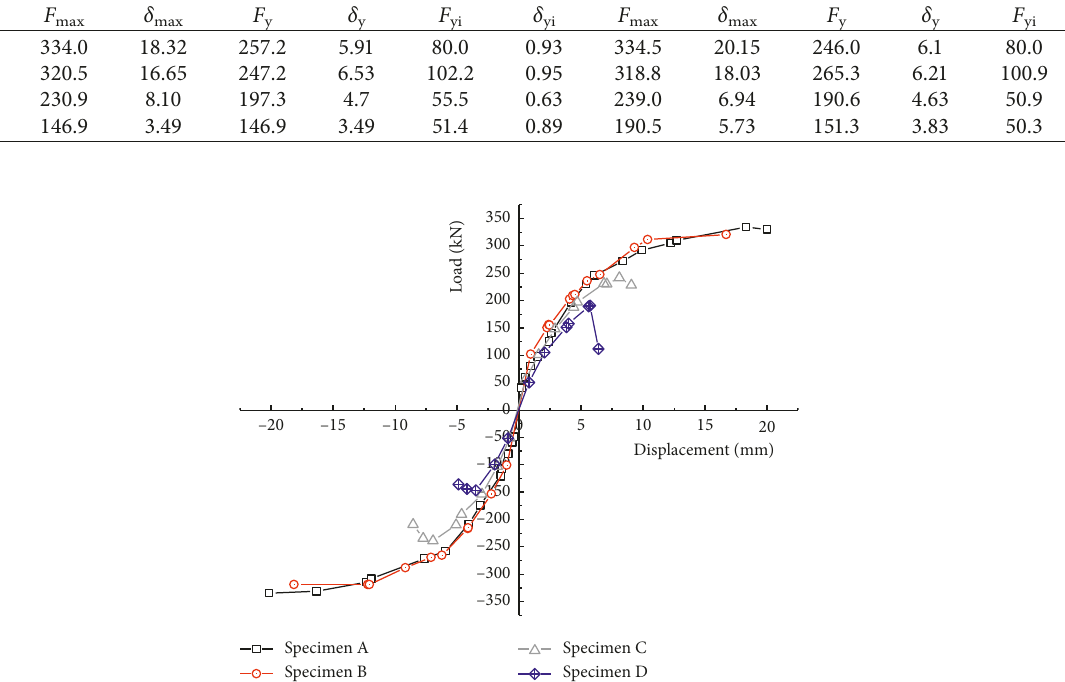
Figure 9: Envelopes of load-top displacement curve of test specimens (reproduced with permission from Lv et al. [16]).